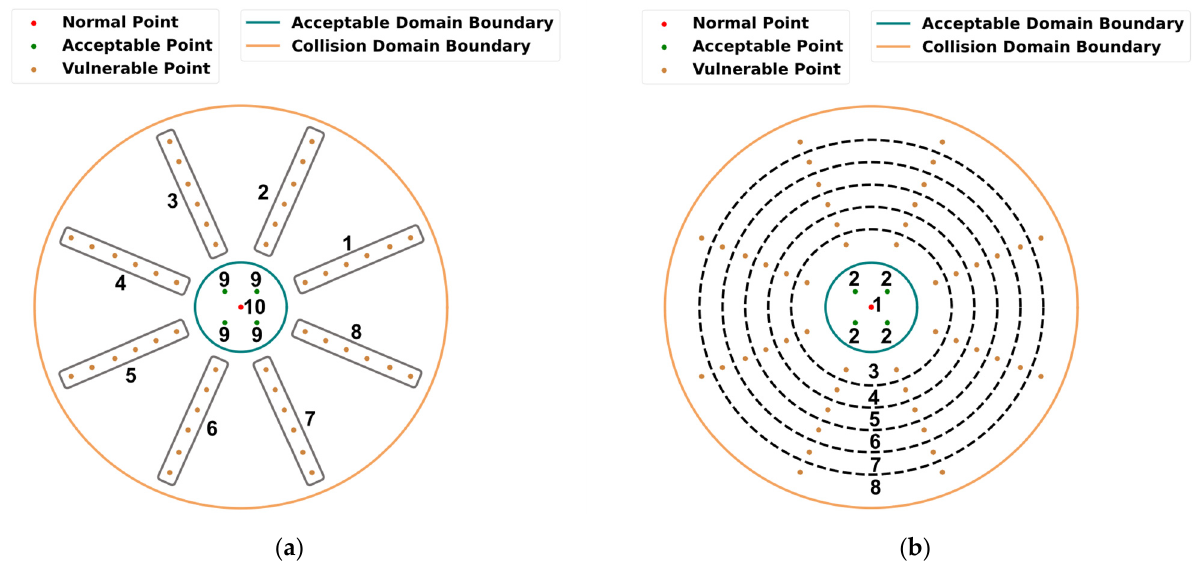
Figure 7. ( a ) The label diagram for collision localization along the circumferential direction; ( b ) the label diagram for collision localization along the radial direction.